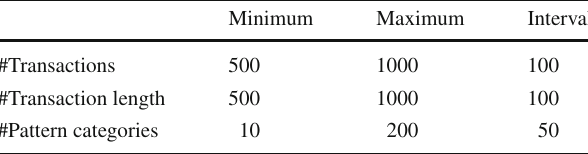
Table 3 Parameter settings for mining of repeating patterns